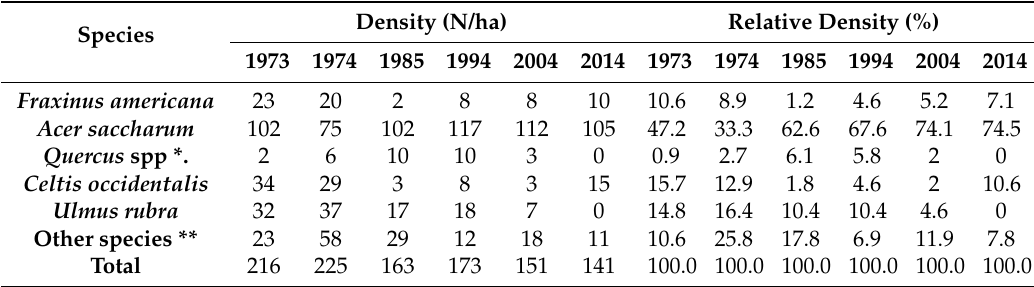
Table 3. Density (N/ha) and Relative Density for the dominant tree species in the subcanopy (DBH